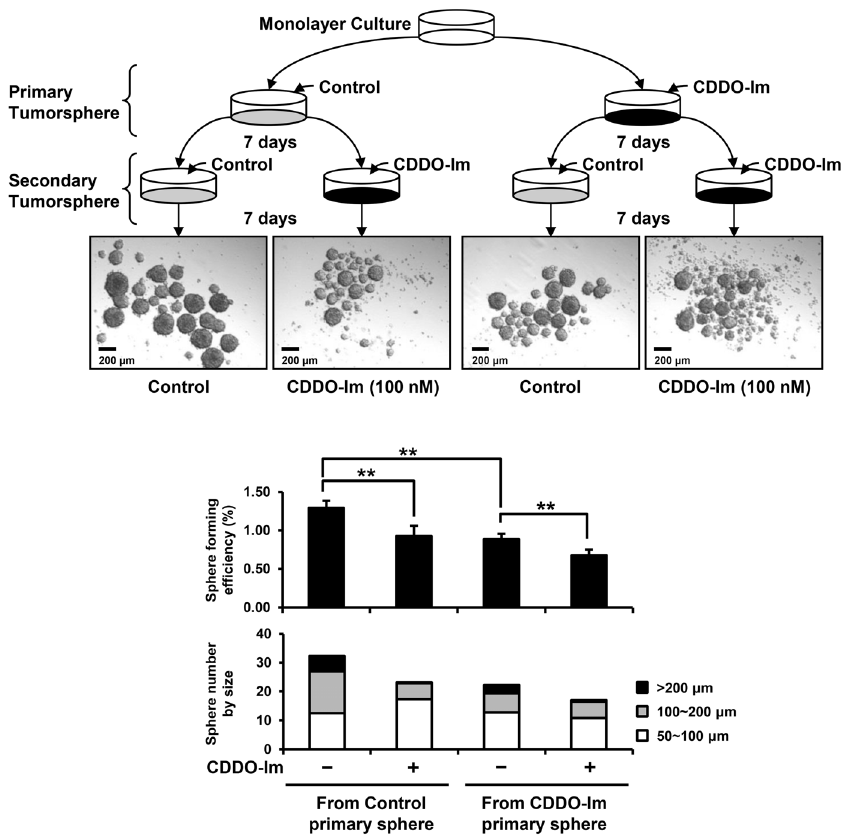
Figure 5. Repression of sphere forming efficiency and size of SUM159 tumorspheres by CDDO-Im in secondary sphere culture. SUM159 cells were harvested separately from primary spheres treated with vehicle control (control primary spheres) or CDDO-Im (CDDO-Im primary spheres). Then the SUM159 cells were incubated with vehicle control or CDDO-Im (100 nM) for secondary sphere culture as shown in the diagram. Representative microphotographs of secondary tumorspheres after 7-day incubations are shown. Two separate experiments with triplicates were conducted. Averages of the sphere forming efficiency (**p , 0.01) with or without CDDO-Im treatment and average number of tumorspheres in each size range are shown in the graph.